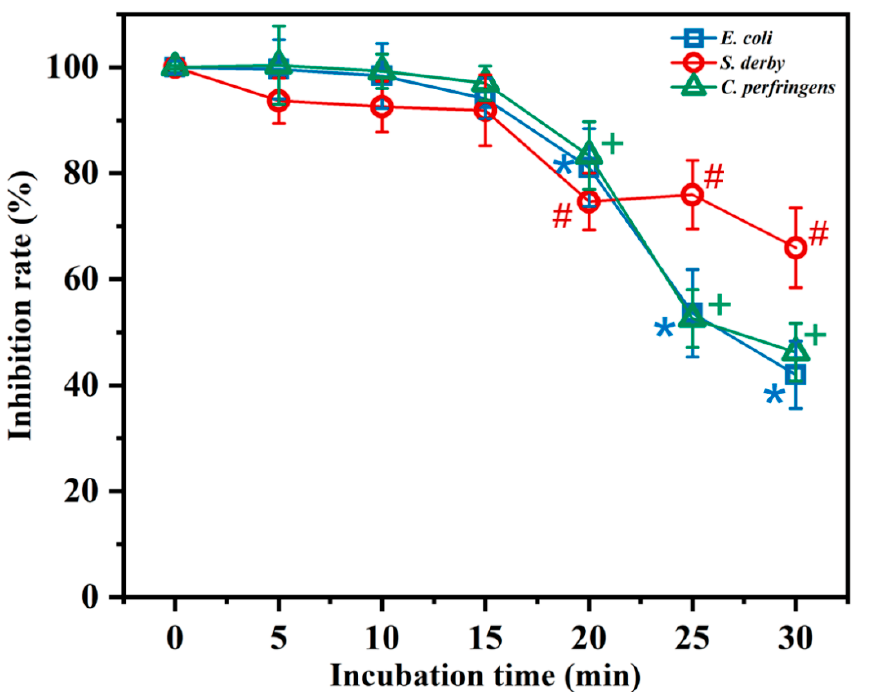
Figure 1. Effect of thermostability on the antimicrobial activity of BMGlv2 against E. coli ATCC 25922, S. derby ATCC 13076, and C. perfringens CVCC 2032. BMGlv2 at the concentrations of its MICs against the three tested bacteria was heated in boiling water at different incubation times (5, 10, 15, 20, 25, and 30 min), and the inhibition rate of BMGlv2 against the three tested bacteria was measured and calculated. *, #, and + represent the significant differences among different incubation times of BMGlv2 compared with the zero-time point of the inhibition rate of E. coli ATCC 25922, S. derby ATCC 13076, and C. perfringens CVCC 2032, respectively. Statistical analysis was calculated using variance ( t -test) with IBM SPSS Statistics 26 software ( p < 0.05), and the results were given as the mean ± standard deviation (SD).